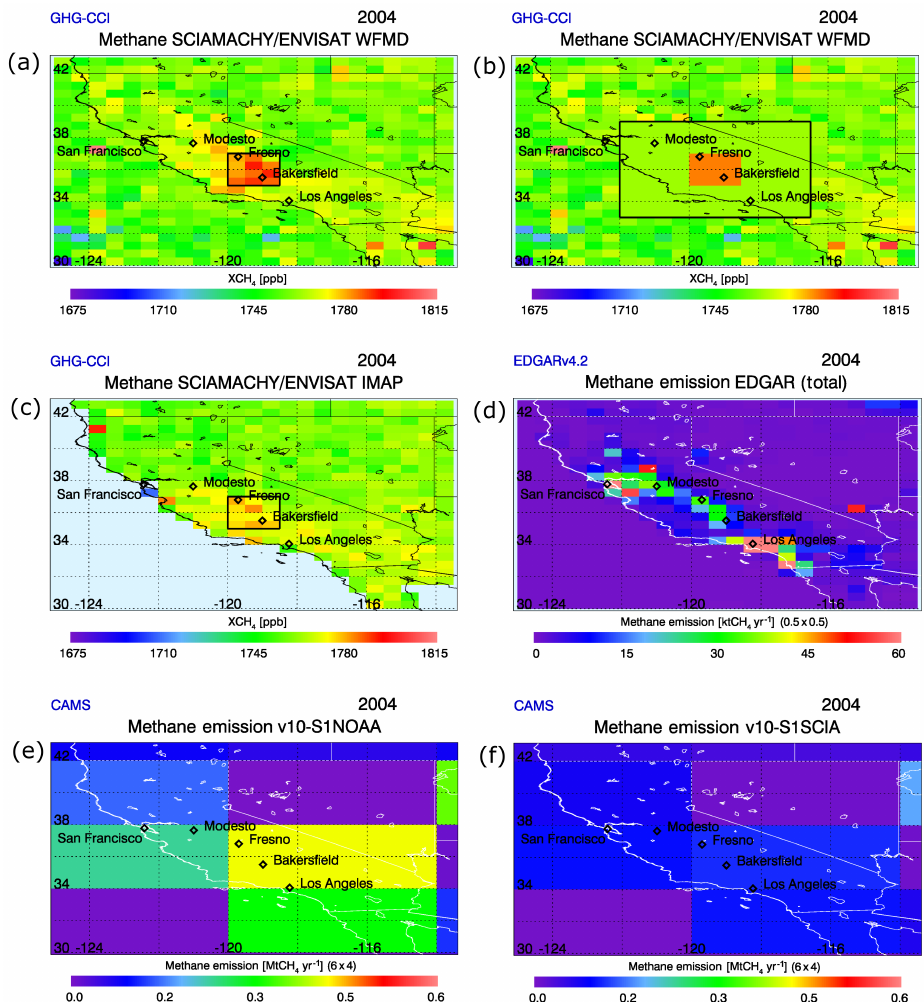
Figure 17. Methane maps for Central Valley, California. (a) SCIAMACHY year 2004 WFMD X CH 4 at 0.5 ◦ × 0.5 ◦ resolution. The rectangle shows the chosen source region. (b) As (a) but showing the source region (inner rectangle) and the default background region (outer rectangle) with their corresponding X CH 4 mean values. (c) As (a) but for IMAP. (d) EDGAR v4.2 year 2004 total anthropogenic methane emissions (regridded to 0.5 ◦ × 0.5 ◦ resolution). (e) CAMS v10-S1NOAA year 2004 total methane, i.e. anthropogenic and natural, emissions obtained by assimilation of NOAA methane observations (at 6 ◦ × 4 ◦ ). (f) As (e) but for CAMS version v10-S1SCIA, i.e. including the assimilation of SCIAMACHY IMAP retrievals in addition to the assimilation of NOAA